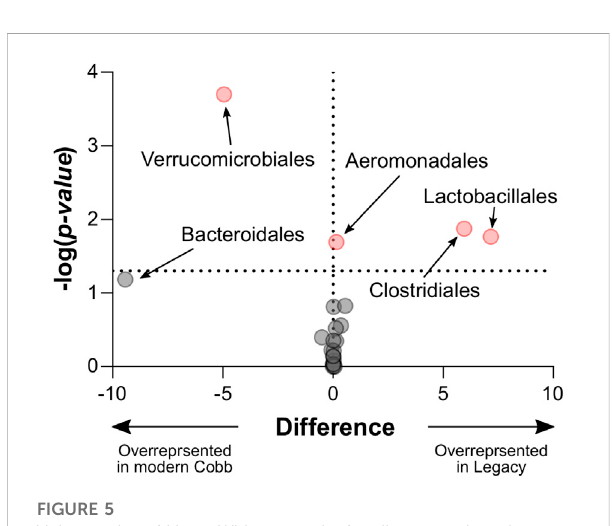
FIGURE 5 Volcano plot of Mann-Whitney results for all taxonomic orders. Signi fi cantly different orders are marked red. Legacy n = 9, Cobb n =